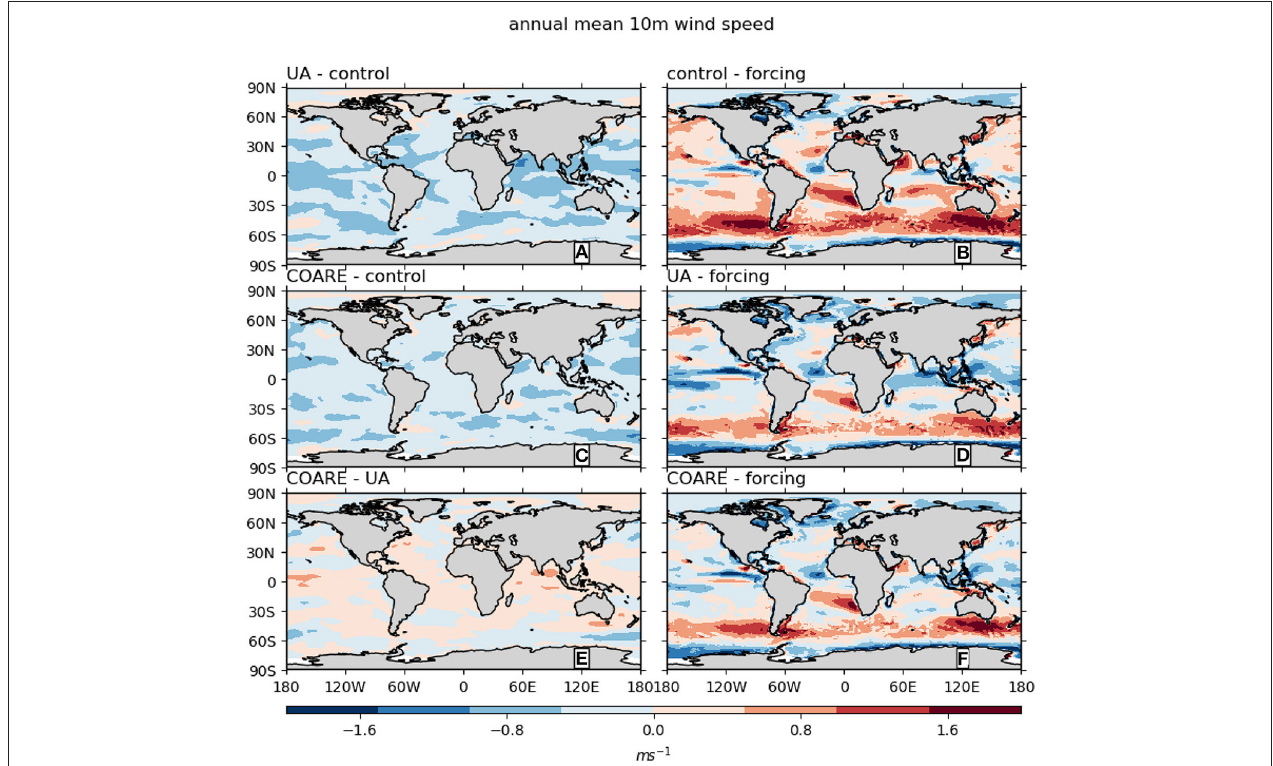
FIGURE 2 | Annual mean 10-m wind speed difference between (left column) pairs of atmosphere model runs and (right column) atmosphere model runs and forcing data used in ocean model runs. The same observation-based wind forcing is used for all three ocean model runs.